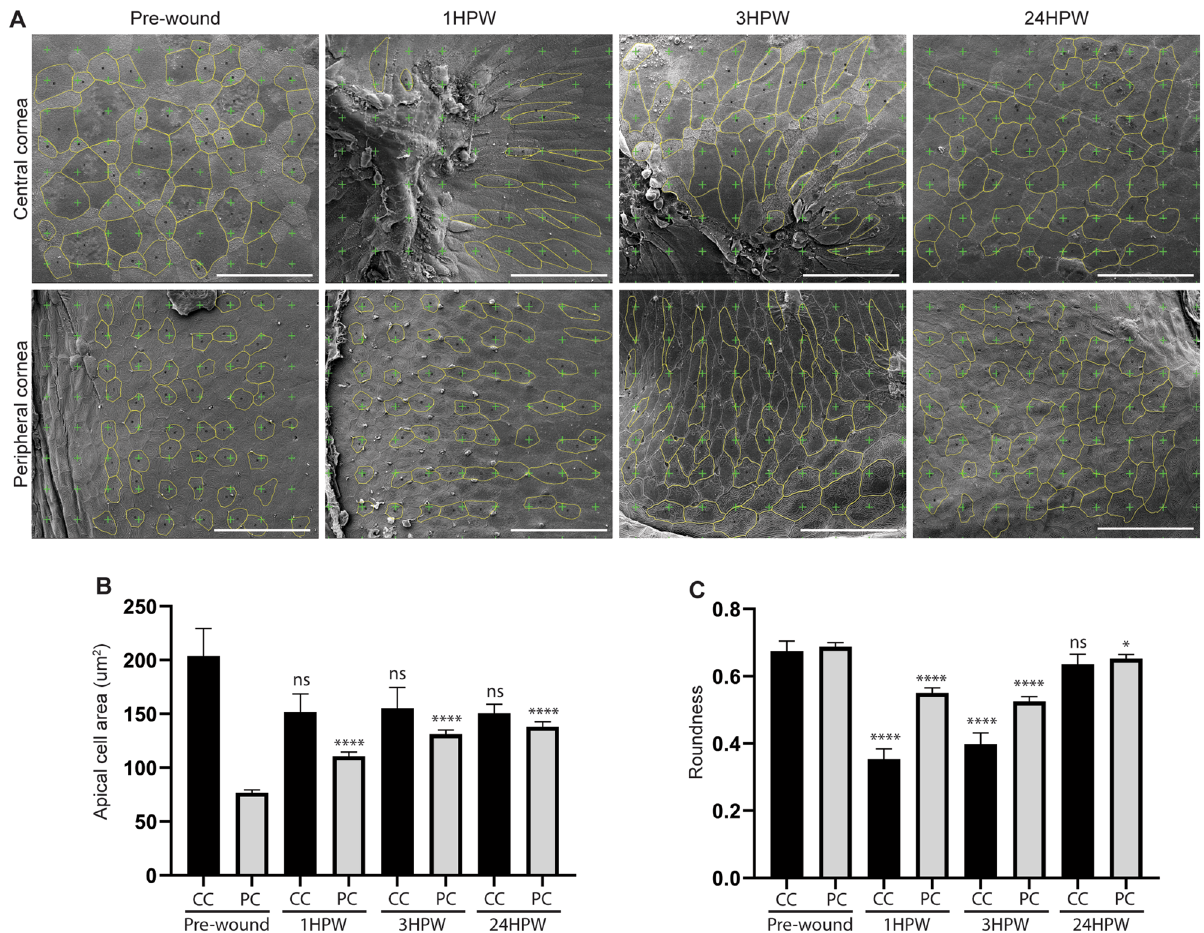
Figure 4. Changes in apical cell area and roundness on wounded cornea. ( A ) Representative SEM images showing cell shape descriptor analysis before wounding, and 1-, 3-, and 24HPW on central and peripheral regions. ( B ) The quantification of apical cell area shows a significant increase of apical cell area on peripheral cornea after wounding, and during 24 h. Cells from 3 eyes were pooled for analysis. ( C ) The quantification of roundness shows a significan decrease of cell roundness in peripheral and central cornea at 1 and 3 HPW. At 24 HPW, the decrease was significant only in the peripheral cornea. Cells from 3 eyes were pooled for analysis. Data represent mean + 95% confidence interval, P ** < 0.01, P *** < 0.001, P *** < 0.0001, Kruskal–Wallis test followed by Dunn’s test for multiple comparisons. For both B and C, n = 106, 85, 84, and 95 on CC, and 442, 461, 510, and 492 on PC, for pre-wound, 1HPW, 3HPW, and 24HPW, respectively. CC: central cornea, PC: peripheral cornea. Scale bars: 50 µm. HPW: hours